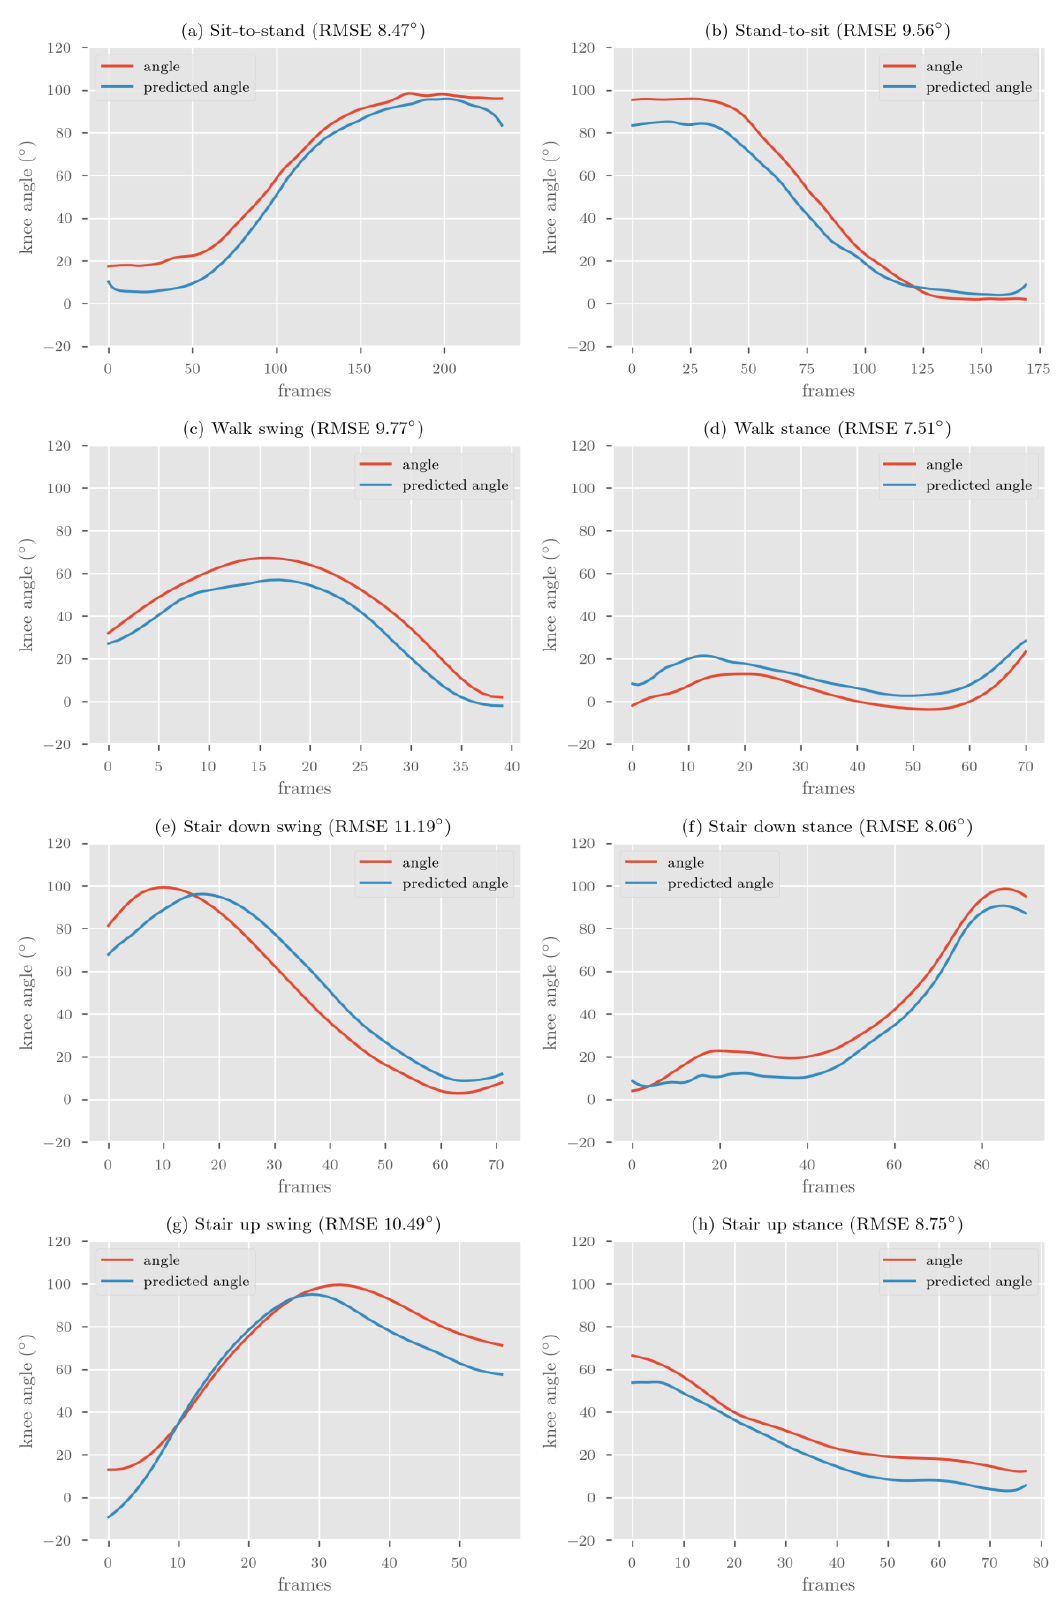
Figure 3. Representative single-leg BiLSTM model prediction compared to Vicon reference for each activity phase .